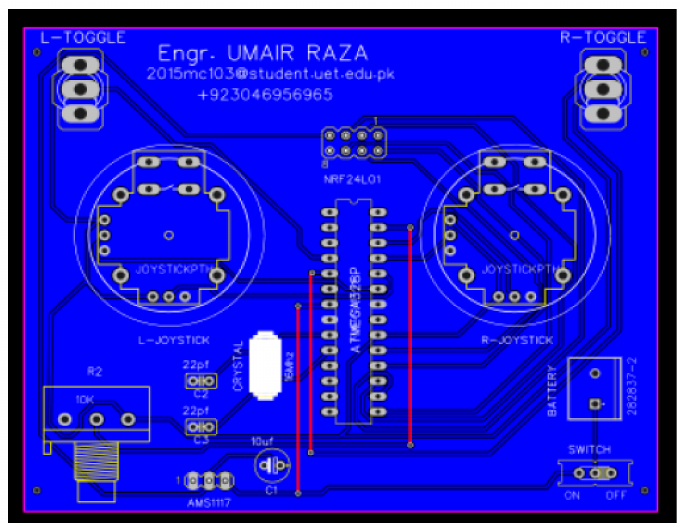
Figure 16. Schematic view of Radio Controller.